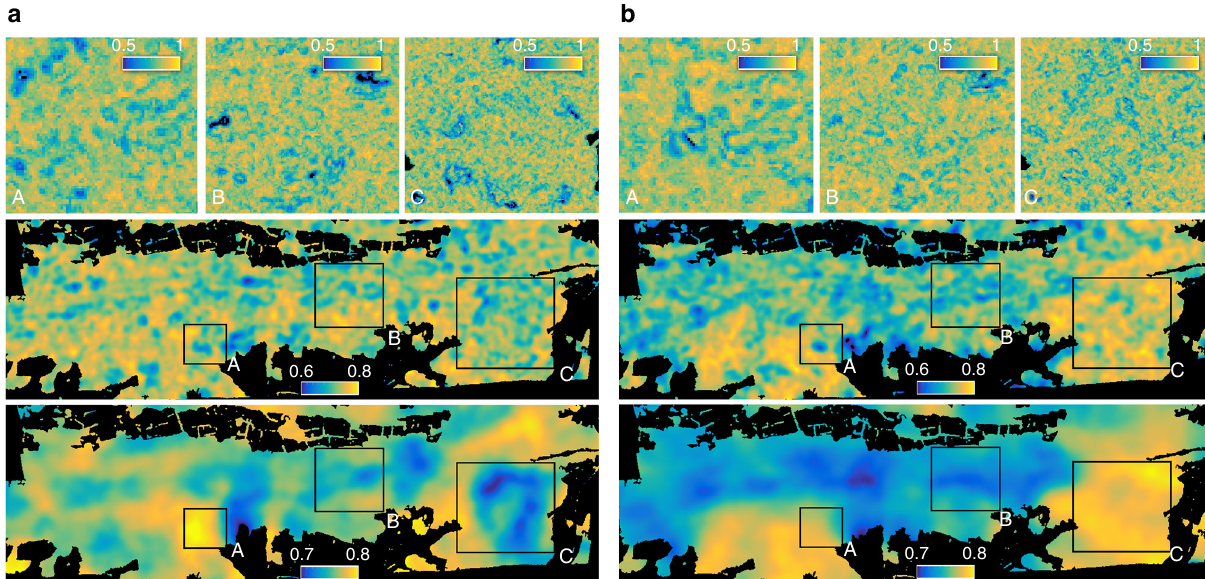
Fig. 7 Spatial patterns of morphological and physiological evenness at three different scales. Functional evenness was computed at 12 m (top), 60 m (middle) and 240 m (bottom) radius based on a morphological traits and b physiological traits. At 12 m radius (top panels), subregions A, B and C are plotted only. The colour is scaled from the lowest (dark blue) to the highest (yellow) evenness value with a maximum possible range from 0 to 1